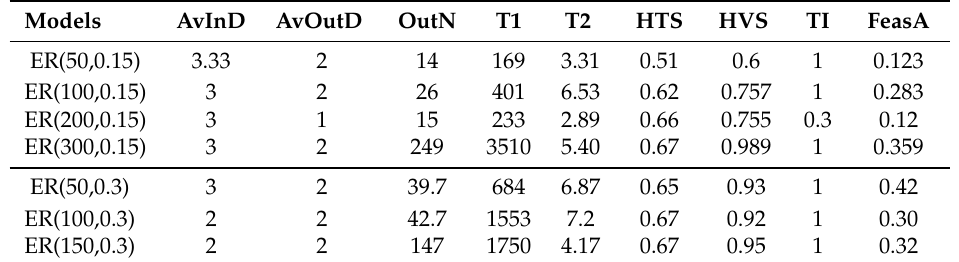
Table 1. The following observations emerged from the results. Table 1. Performances: Models (Erdos–Renyi); average input diameter (AvInD); average diameter (AvOutD); output nodes (OutN); user (T1) and system Time (T2) in seconds; average entropy of f Y (HTS); average entropy of f S (HVS); target included, average number (TI); Avnumber of feasible vertices (%) w.r.t. the number of vertices in the final solution